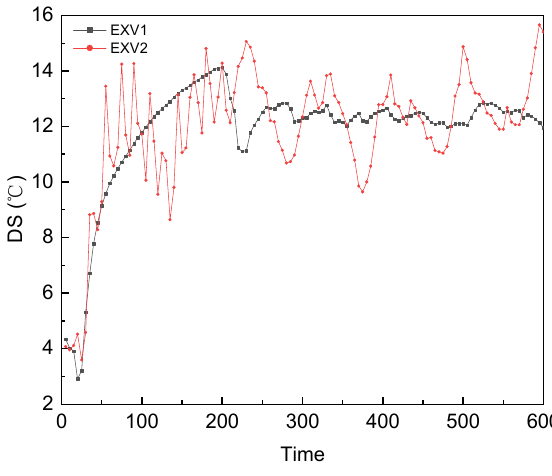
Figure 9. Manual control response curves.